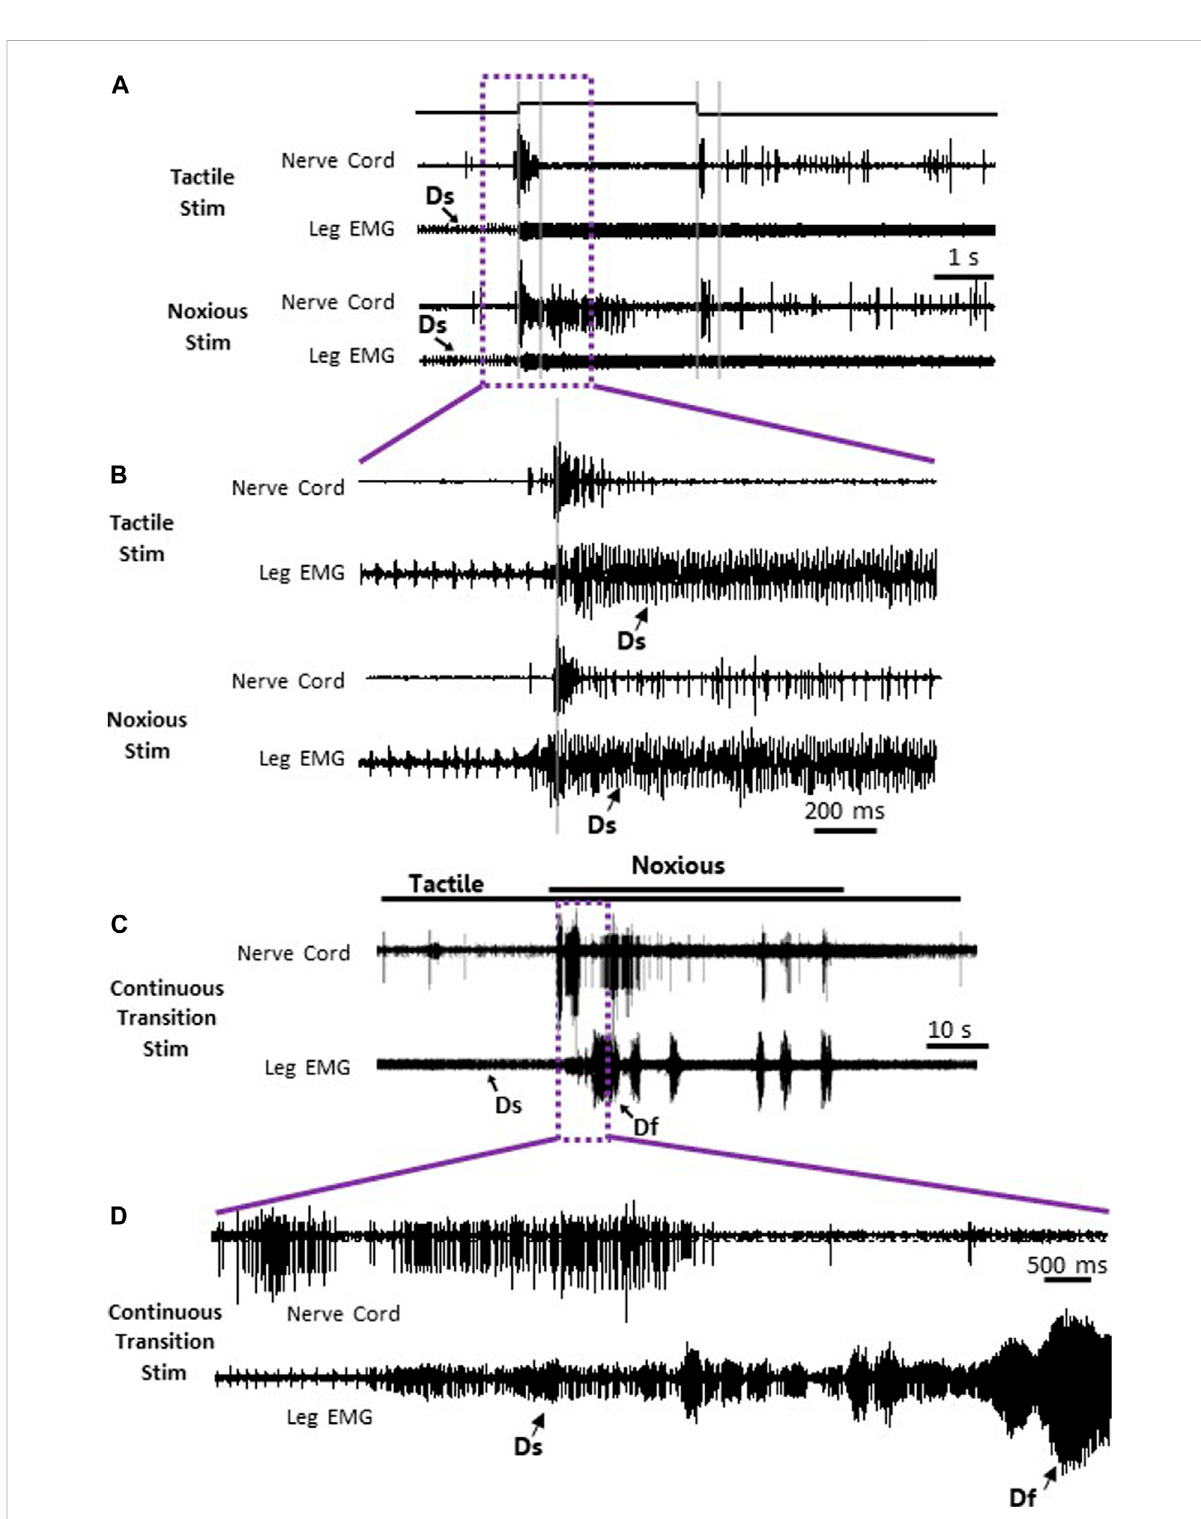
FIGURE 2 Nociceptiveandtactileinformationiscarriedforwardbypost-synapticinterneuronsinthenervecordofstungcockroaches. (A) Representative example recordings of post-synaptic interneurons in the nerve cord (upper trace of each stimulus example) and the leg EMG (lower trace of each stimulus type) following a brief (3 s) tactile (two upper traces) and noxious (two lower traces) stimuli. Vertical grey lines represent a time division (0 – 0.4,0.4 – 3, and 3 – 3.4 s) corresponding to onset, duration,and offset ofthe stimulus, respectively. Activity ofthe slow motor neurons (Ds) is indicated on the leg EMG traces. (B) Enlarged view of traces in purple box in panel (A) . (C) Representative example of simultaneous recordings from post-synaptic interneurons in the nerve cord (upper trace) and the leg EMG (lower trace) following a continuous transition between tactile and noxiousstimuli.Stimulusdurationisindicatedwithhorizontallines(upperline:noxious;lowerline:tactile). (D) Enlargedviewoftracesinpurpleboxin panel (C) . Activity of the fast and slow motor neurons (Df and Ds, respectively) is indicated on the leg EMG